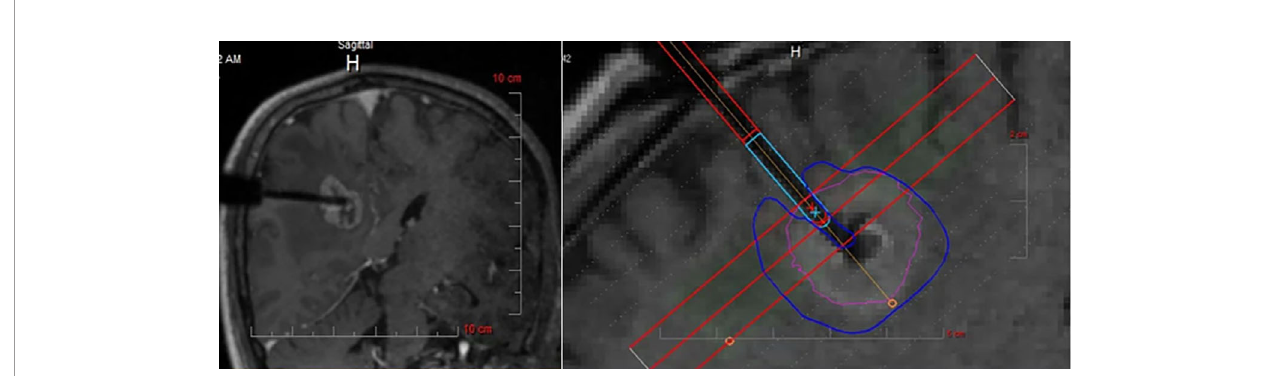
FIGURE 5 | Intraoperative MRI monitoring of LITT after stereotactic placement of the laser electrode. The heat maps are presented showing temperature-dependent colors during treatment. MRI, magnetic resonance imaging; LITT, laser interstitial thermal therapy. Modi fi ed from Ferguson et al.